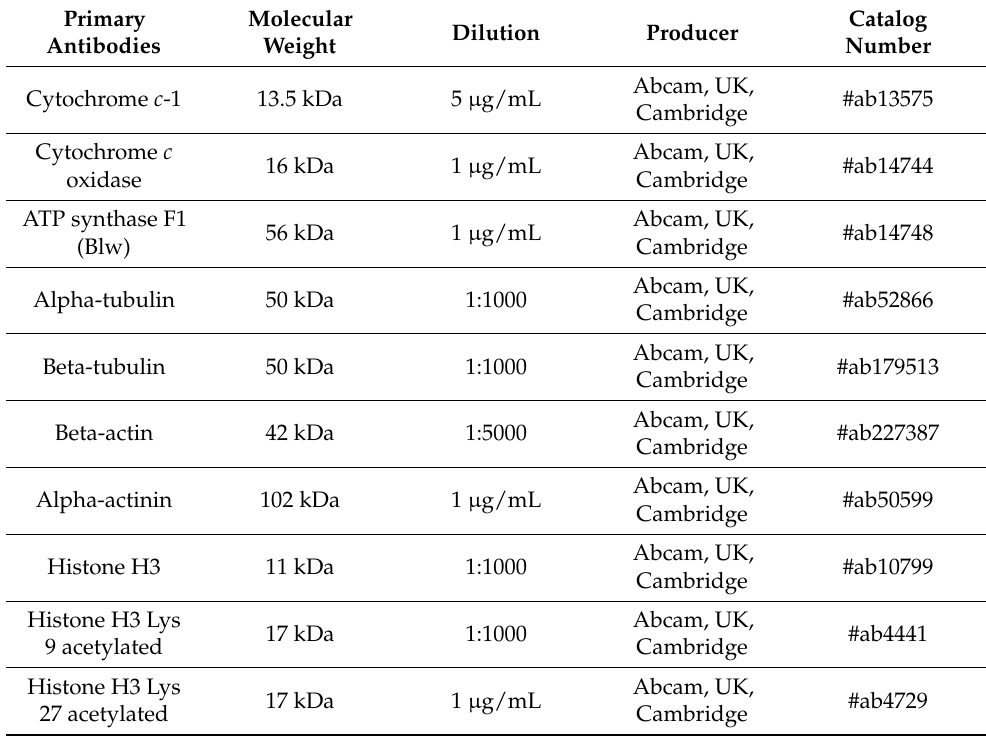
Table 1. Primary